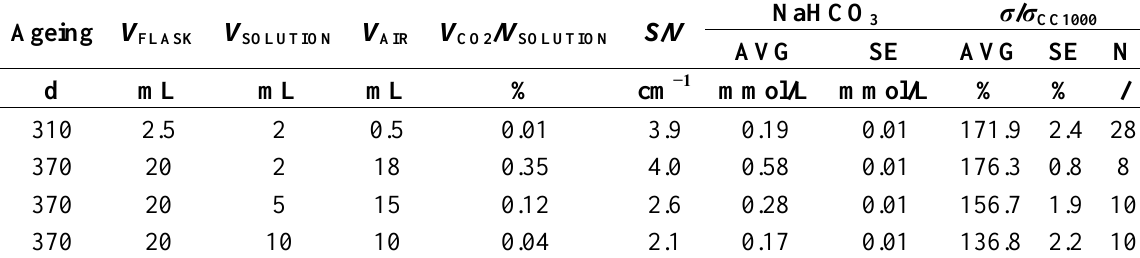
Table 2. Influence of dissolved CO Conductivity measured at 25 °C and 1000 Hz, treatments are